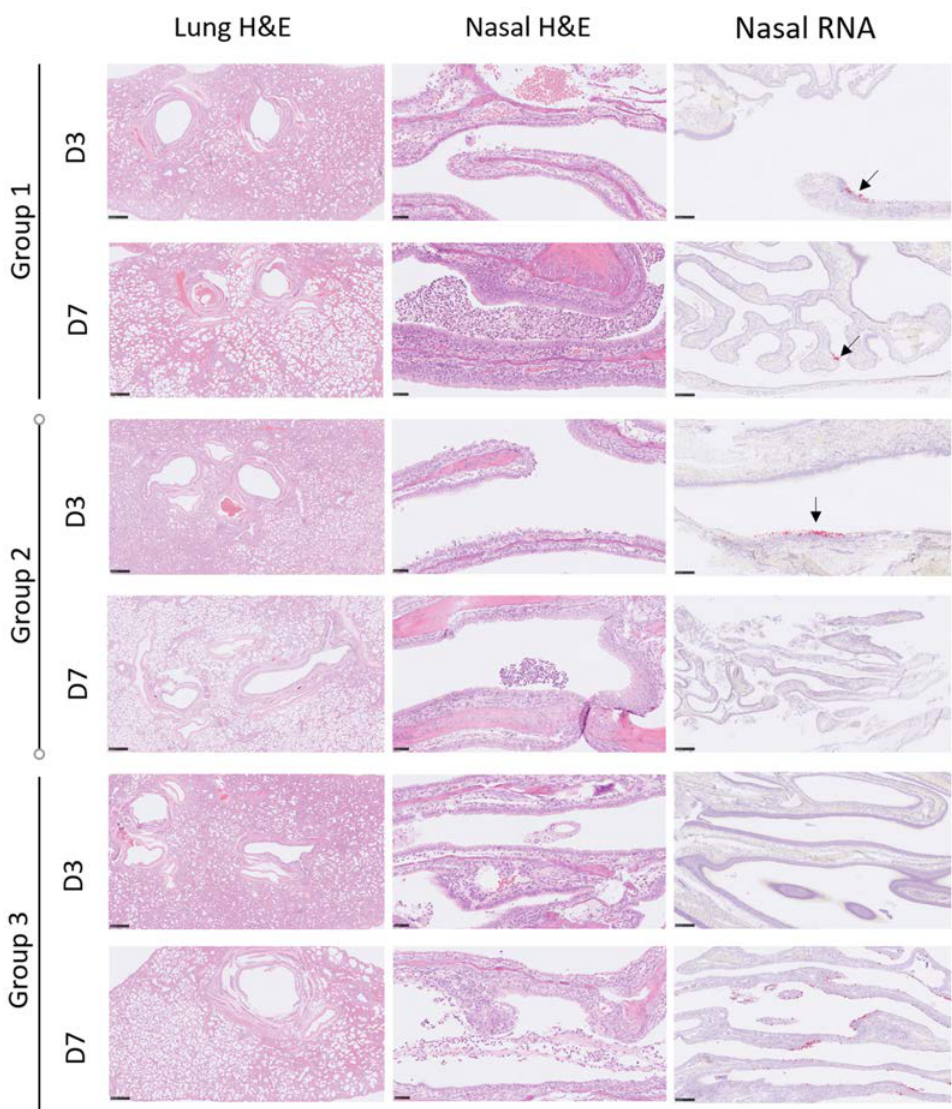
Figure 4. Histopathological changes in the lung and nasal cavity, and viral RNA staining in the nasal cavity. Column one: lung H&E, with low-grade inflammatory infiltrations. Column two: nasal H&E, with inflammatory exudation in the lumen and respiratory epithelial degeneration. Column three: nasal RNA, with staining of SARS-CoV-2 RNA in the epithelia (arrows highlight smaller patches of viral-positive cells).